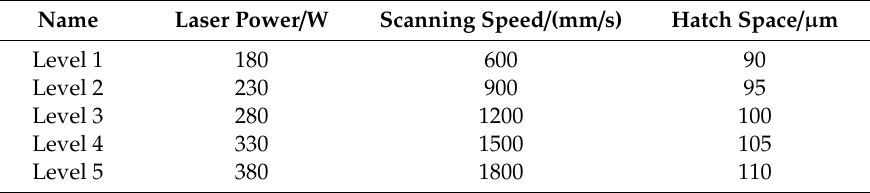
Table 2. Process parameters of orthogonal experiment.